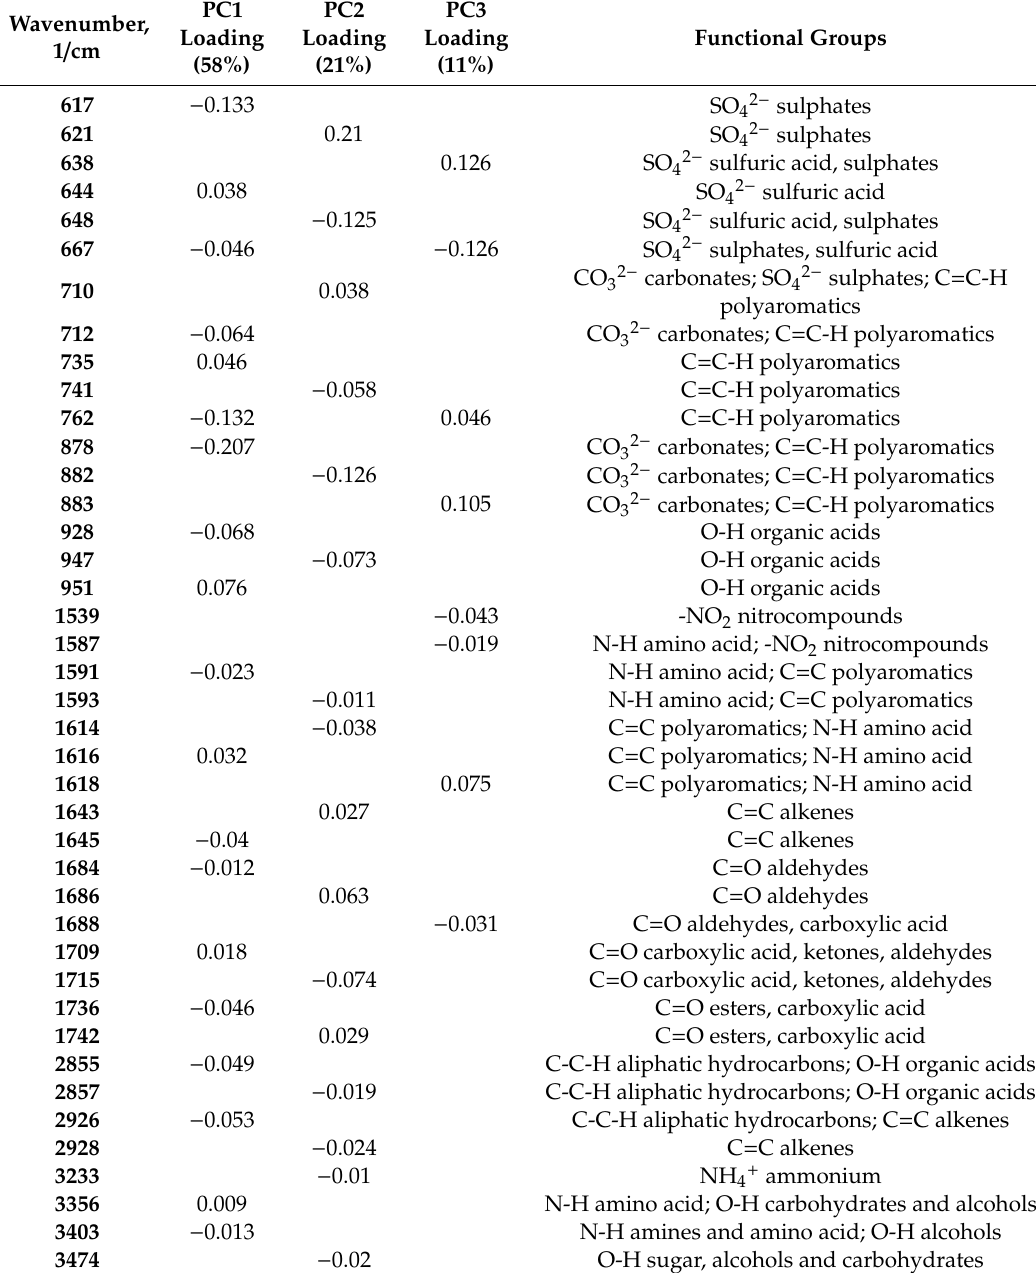
Table 2. Functional factors presented by principal components of PCA analysis of FTIR